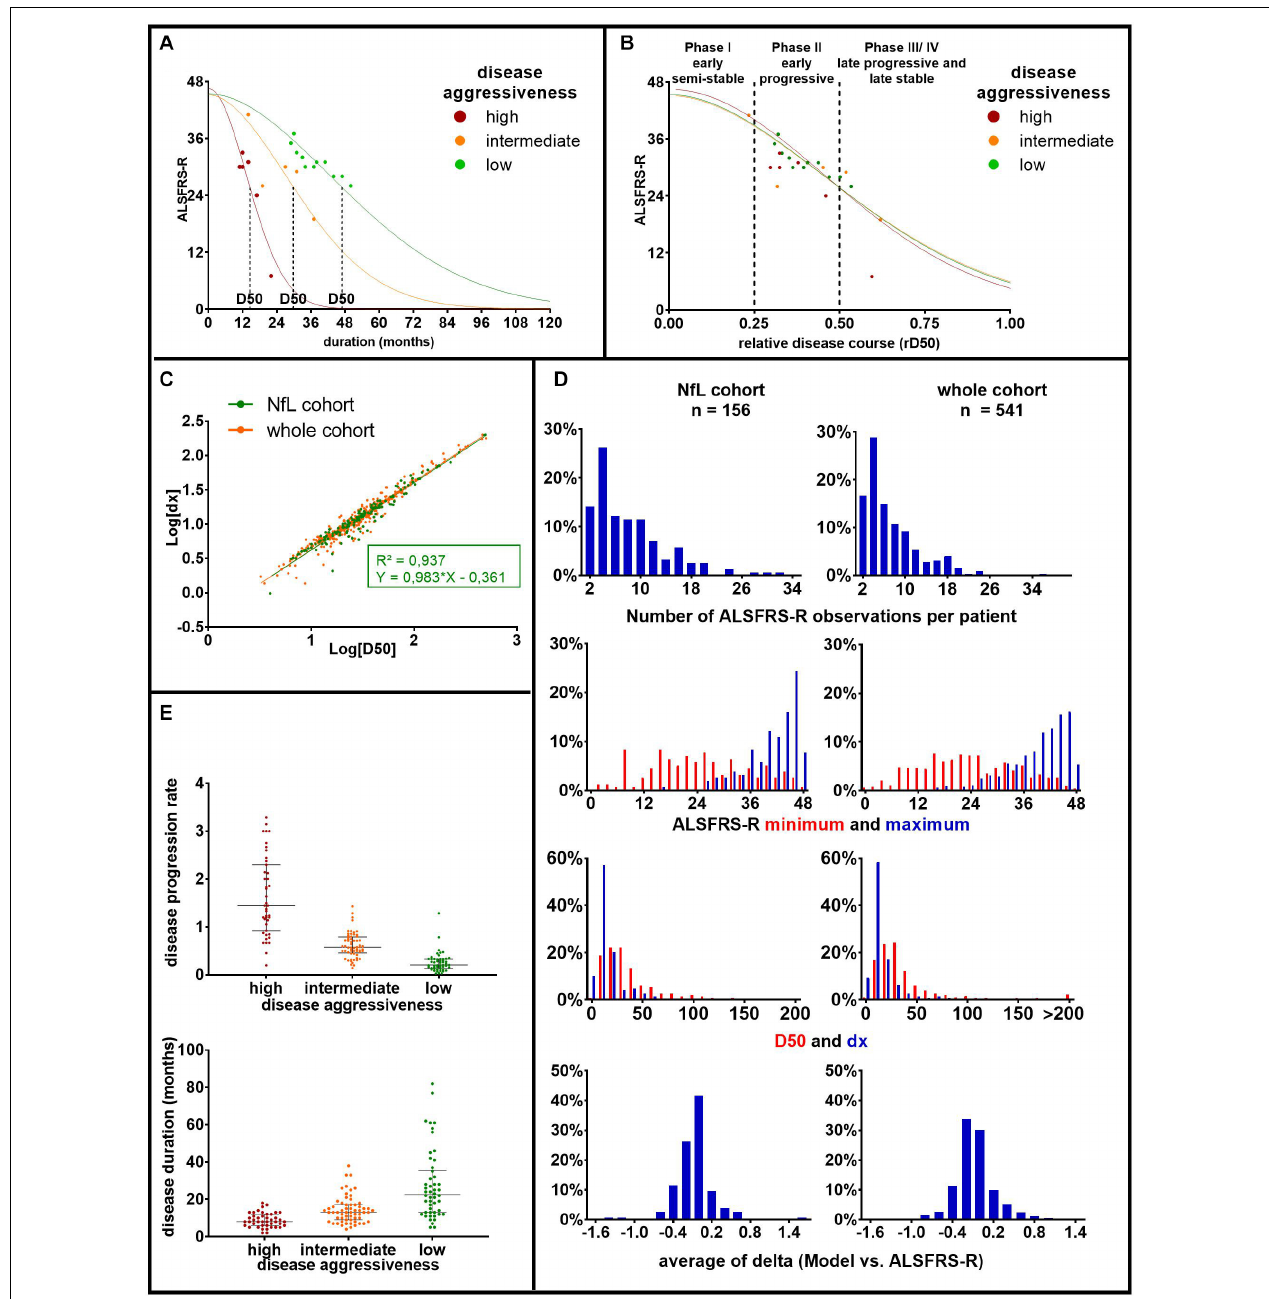
FIGURE 1 | Principles and parameters of the D50 model: (A) based on consecutively obtained ALSFRS-R scores (dots), a sigmoidal functional decline curve is calculated. The value D50 depicts the individual time in months since symptom onset until halved functionality, indicating the overall disease aggressiveness of each individual patient. The curves represent three example patients with either high (D50 = 14.56 months, in red), intermediate (D50 = 29.88 months, in orange), or low disease aggressiveness (D50 = 46.84 months, in green). (B) Normalization of patient’s individual sigmoidal curves by D50 yields the parameter relative D50 (rD50). rD50 describes the individual disease covered and facilitates the comparison of vastly differing progression types. (C) The parameter D50 linearly correlates with the time constant of ALSFRS-R decline (dx) in this, as well as in other ALS cohorts. Thus, D50 alone can be used to describe patients’ disease aggressiveness. (D) Histograms of pertinent disease variables for the patients of the current cohort (NfL cohort), as well as all ALS patient data available in our center (whole cohort). It illustrates that the current cohort well coincides with the entire ALS patient cohort treated at our center. (E) Scatterplots of patients’ disease progression rate and disease duration at the time of sampling, subdivided by the three D50 subgroups in our cohort: (a) high (0 ≤ D50 < 20, in red), (b) intermediate (20 ≤ D50 < 40, in orange), and (c) low (40 ≤ D50, in green) disease aggressiveness. It illustrates large variations of the disease progression rate, especially within the high aggressive subgroup. Bars indicate median and interquartile range. ALS, amyotrophic lateral sclerosis; ALSFRS-R, Amyotrophic Lateral Sclerosis Functional Rating Scale-Revised; rD50, relative D50; NfL, neurofilament light chain.